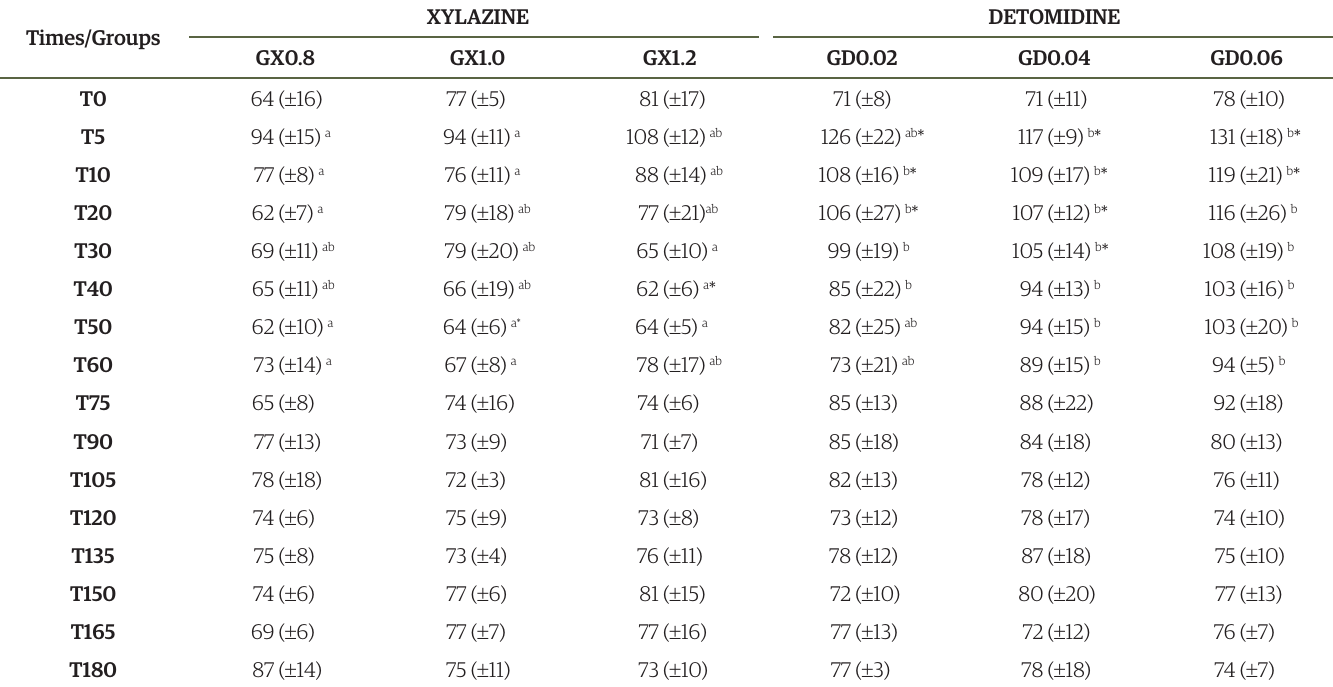
Table 9. Median ( ± Semi-interquartile range) mean arterial pressure (mmHg) in donkeys from northeast Brazil sedated with detomidine or xylazine, given intravenously in different